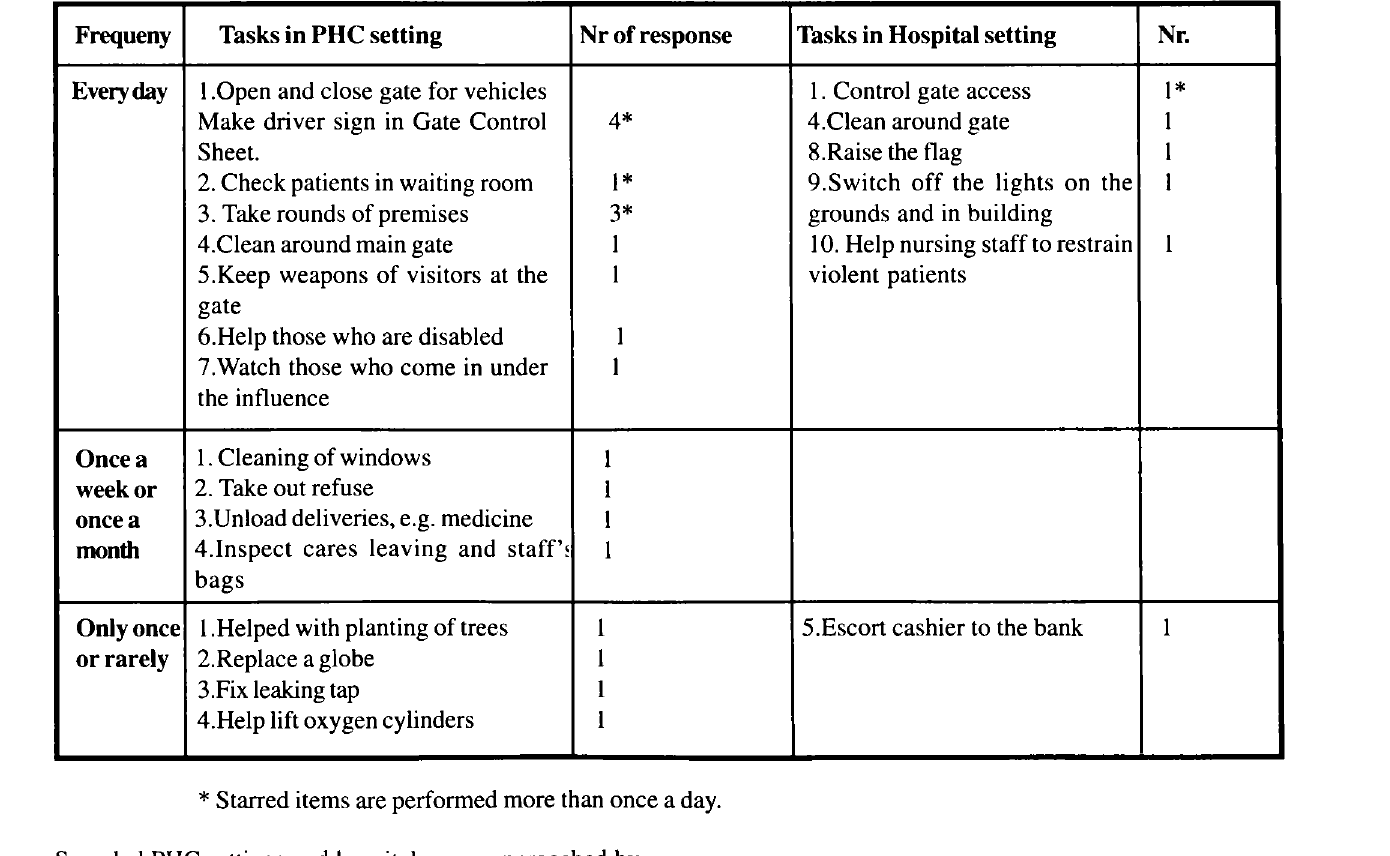
Table 3.2 Tasks of security staff and frequency mentioned in different settings Frequeny Tasks in PHC setting Nr of response Tasks in Hospital setting